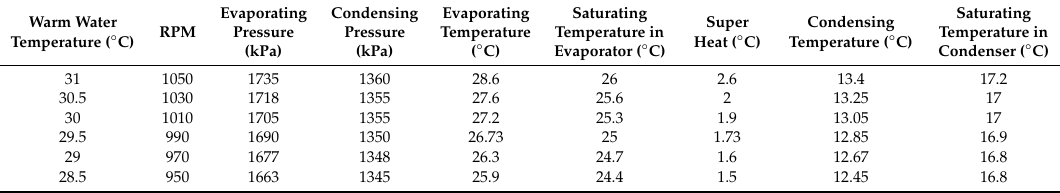
Table 6. Operating fluid pump RPM control range according to the surface water temperature (cold water temperature: 9.5 ◦